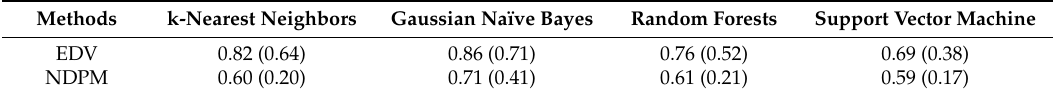
Table 1. Performance of Earthquake Damage Visualization (EDV) and NASA Damage Proxy Map (NDPM) based on statistical metrics, overall accuracy (kappa coefficient) calculated from 10-fold cross-validation method using four supervised classifiers.